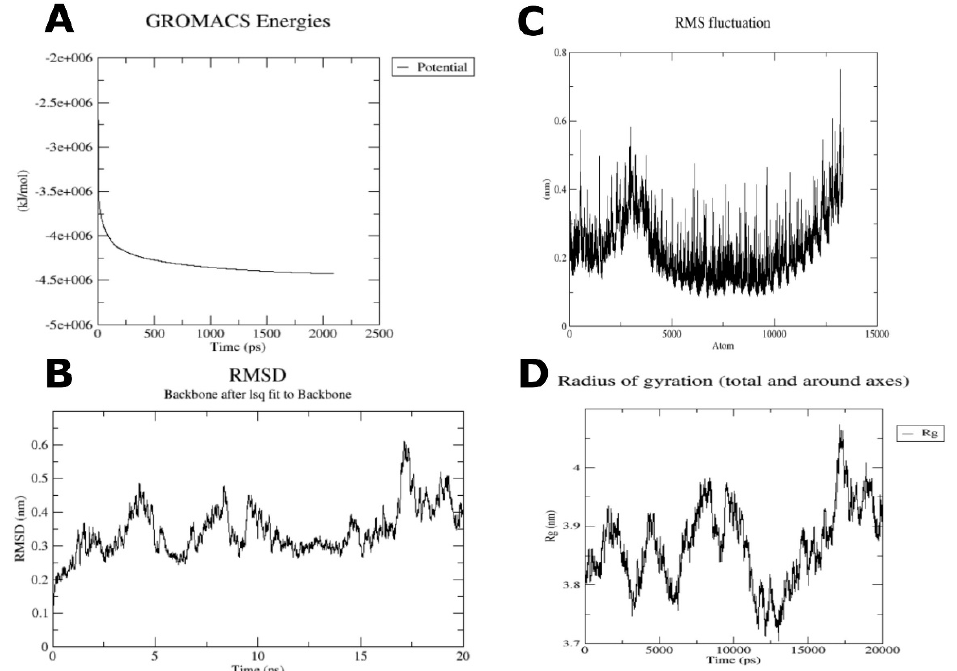
Figure 6. Some graphs obtained after molecular dynamics simulation on the vaccine-TLR4 complex. ( A ) Potential energy during simulation. ( B ) Comparison of backbone RMSD during MD production simulation. ( C ) RMSF of side chains during MD production simulation. ( D ) Radius of gyration with minimum fluctuations, showing compactness of structure during MD production simulation.